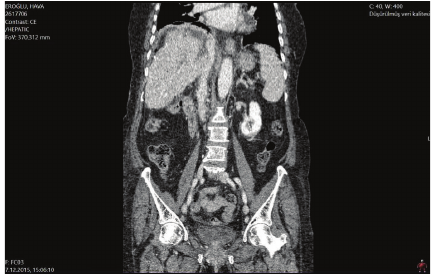
Figure 3: The postoperative sagittal section of the abdominal CT. IVC is seen as